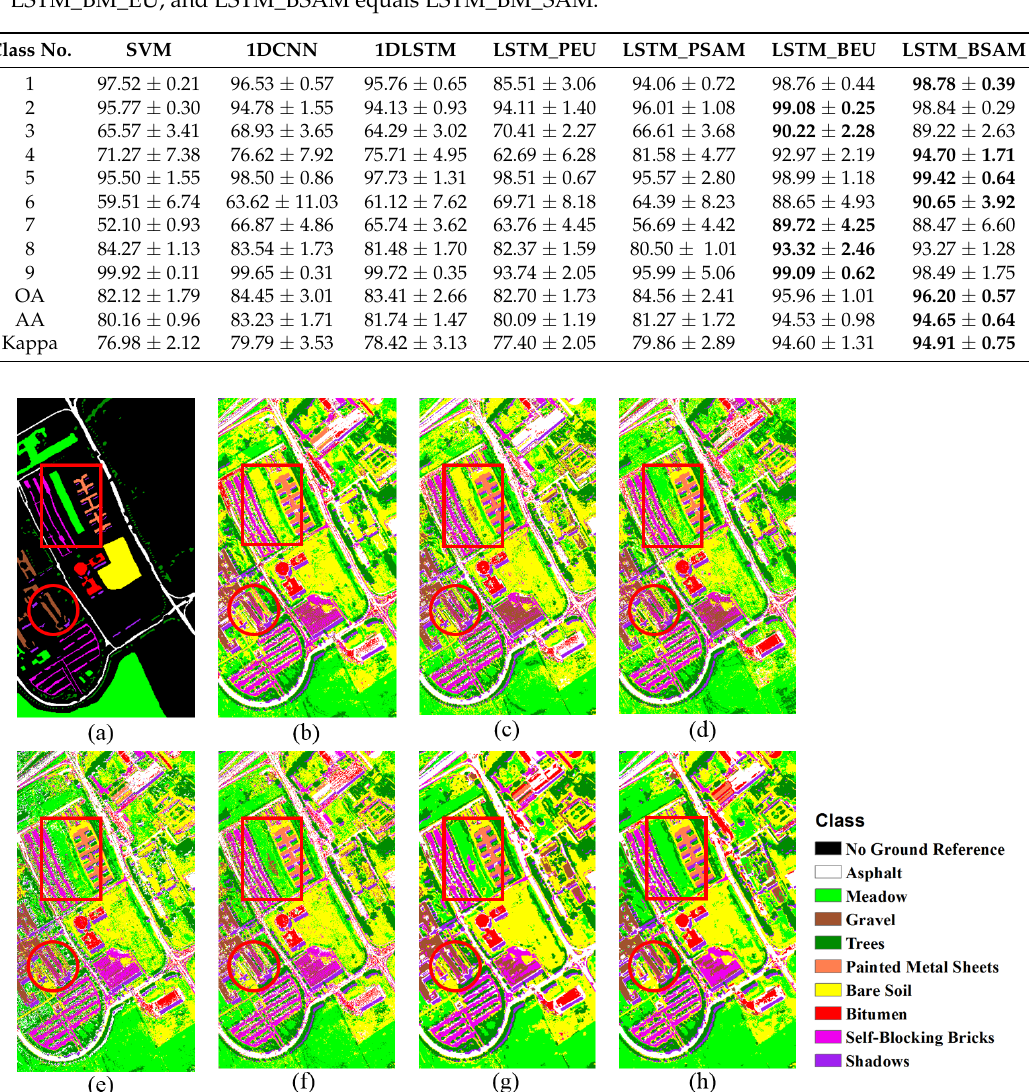
Figure 4. Classification maps for the Pavia University image from the fifth trial: ( a ) ground-reference map; ( b ) SVM, with OA = 80.04%; ( c ) 1DCNN, with OA = 78.32%; ( d ) 1DLSTM, with OA = 83.72%; ( e ) LSTM_PM_EU, with OA = 83.81%; ( f ) LSTM_PM_SAM, with OA = 86.78%; ( g ) LSTM_BM_EU, with OA = 93.18%; and ( h ) LSTM_BM_SAM, with OA = 96.01%. The red-rectangle and red-circle annotations represent sample areas of interest, discussed in the